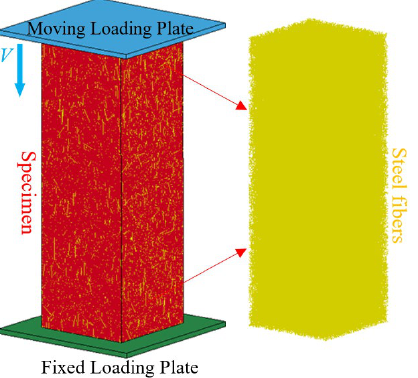
Figure 9. Typical mesoscale FE model for uniaxial compression.